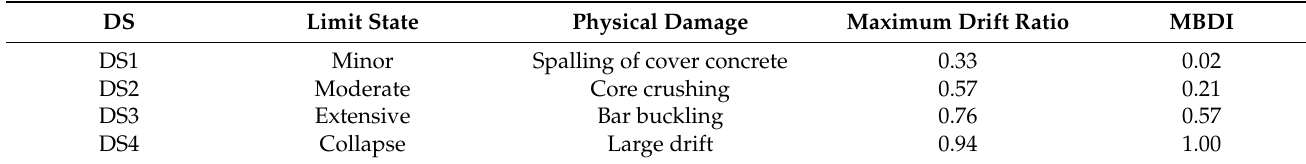
Table 1. Damage states defined in the current